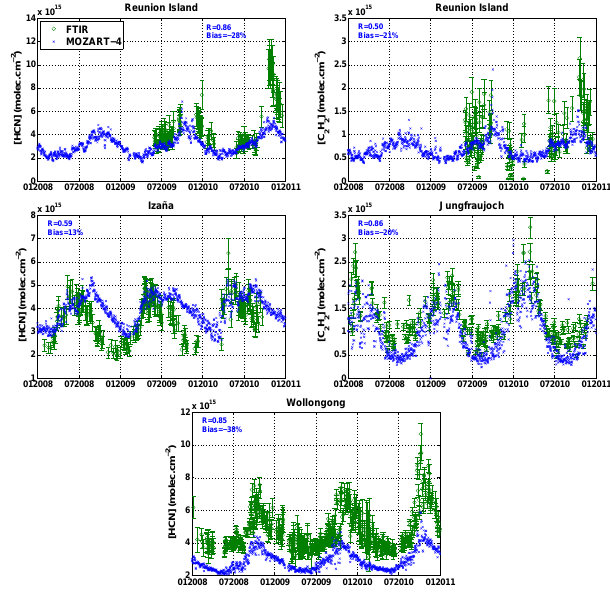
Figure14. TimeseriesofHCN(leftpanel)andC 2 H 2 (rightpanel)measurementsandsimulationsforReunionIsland(HCNandC 2 H 2 ), Figure 14. Time series of HCN (left panel) and C 2 H 2 (right Wollongong (HCN only), Izaña (HCN only), and Jungfraujoch (C 2 H 2 only). MOZART-4 total columns are shown as daily and 1.875 ◦ x 2.5 ◦ means(bluecrosses).Ground-basedFTIRmeasurementsareshownasdailymeanswithassociatedtotalerrorbygreencirclesandlines. panel) measurements and simulations for Reunion Island (HCN and Correlationcoefficientandbiasaregivenoneachplotfordailymeans. C 2 H 2 ), Wollongong (HCN only), Izaña (HCN only), and Jungfrau- joch (C 2 H 2 only). MOZART-4 total columns are shown as daily and 1.875 ◦ × 2.5 ◦ means (blue crosses). Ground-based FTIR mea- surements are shown as daily means with associated total error by green circles and lines. Correlation coefficient and bias are given on each plot for daily